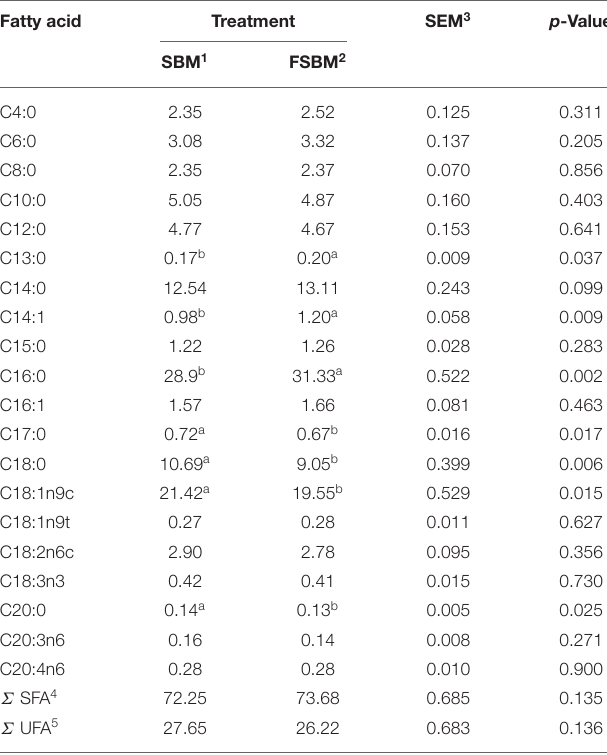
TABLE 2 | Comparison of milk FA proportions (g/100g of FA) between the SBM group and FSBM